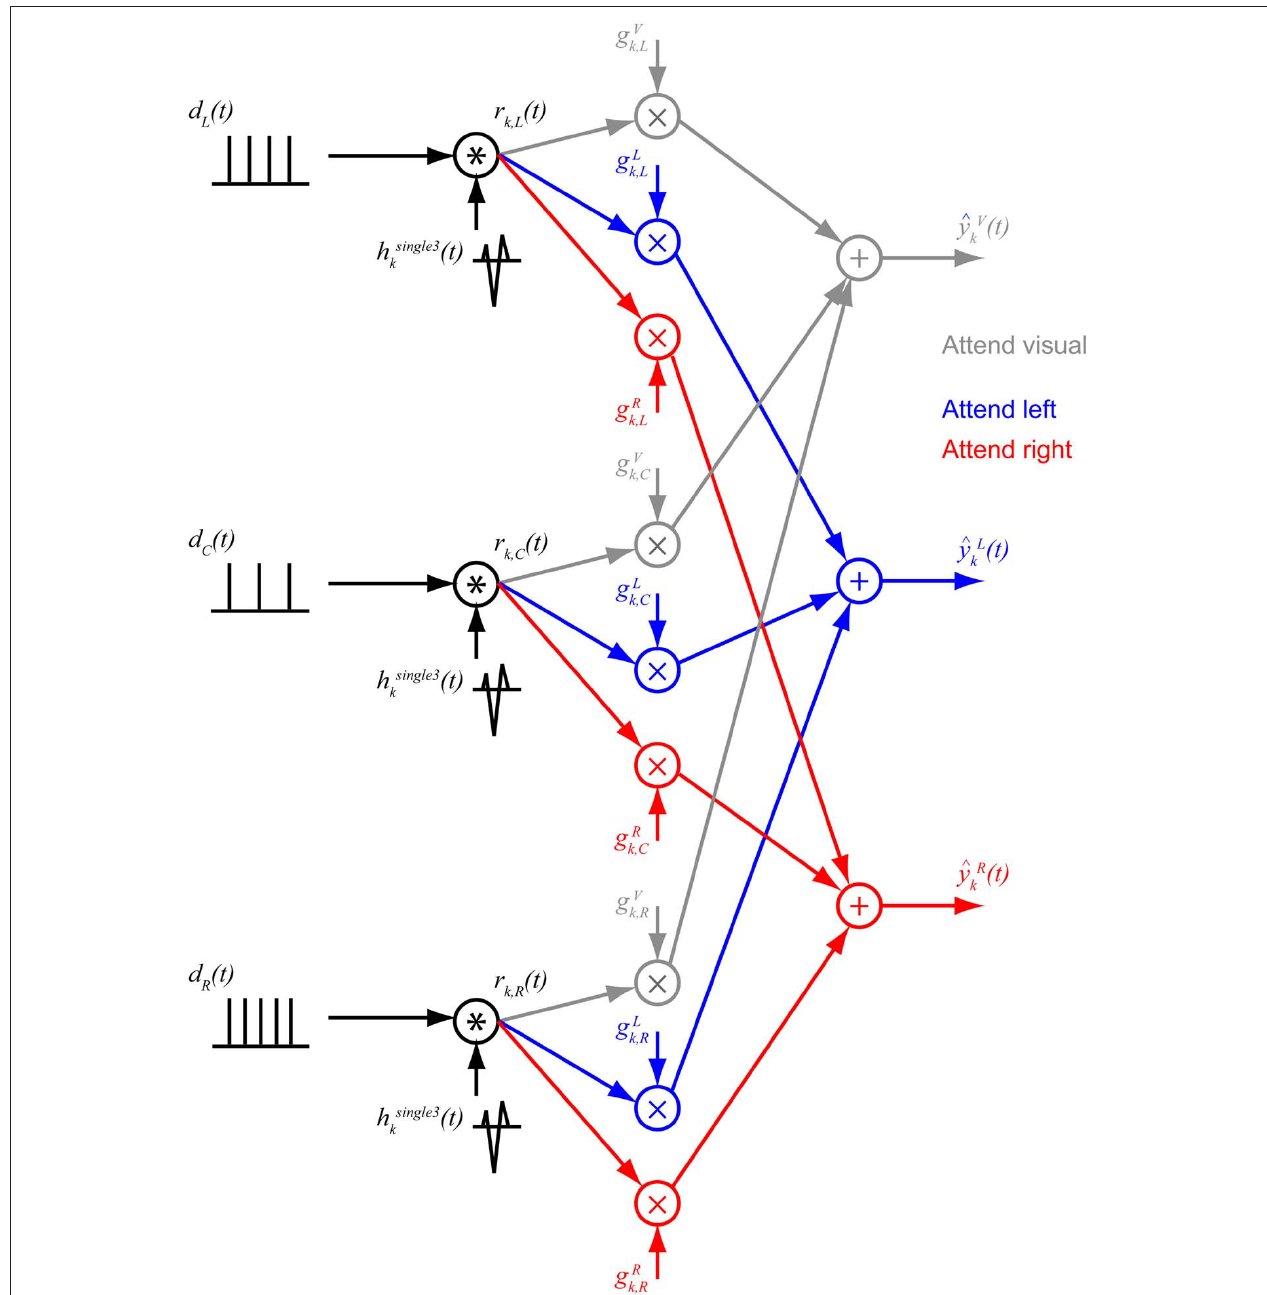
FIGURE 6 | Modeling ERPs. Each stream is assumed to generate a sequence of onset responses corresponding to each note in the stream, the shape of which is equal to a modeled single-note ERP. The resulting signal from each stream is then scaled by a gain factor that